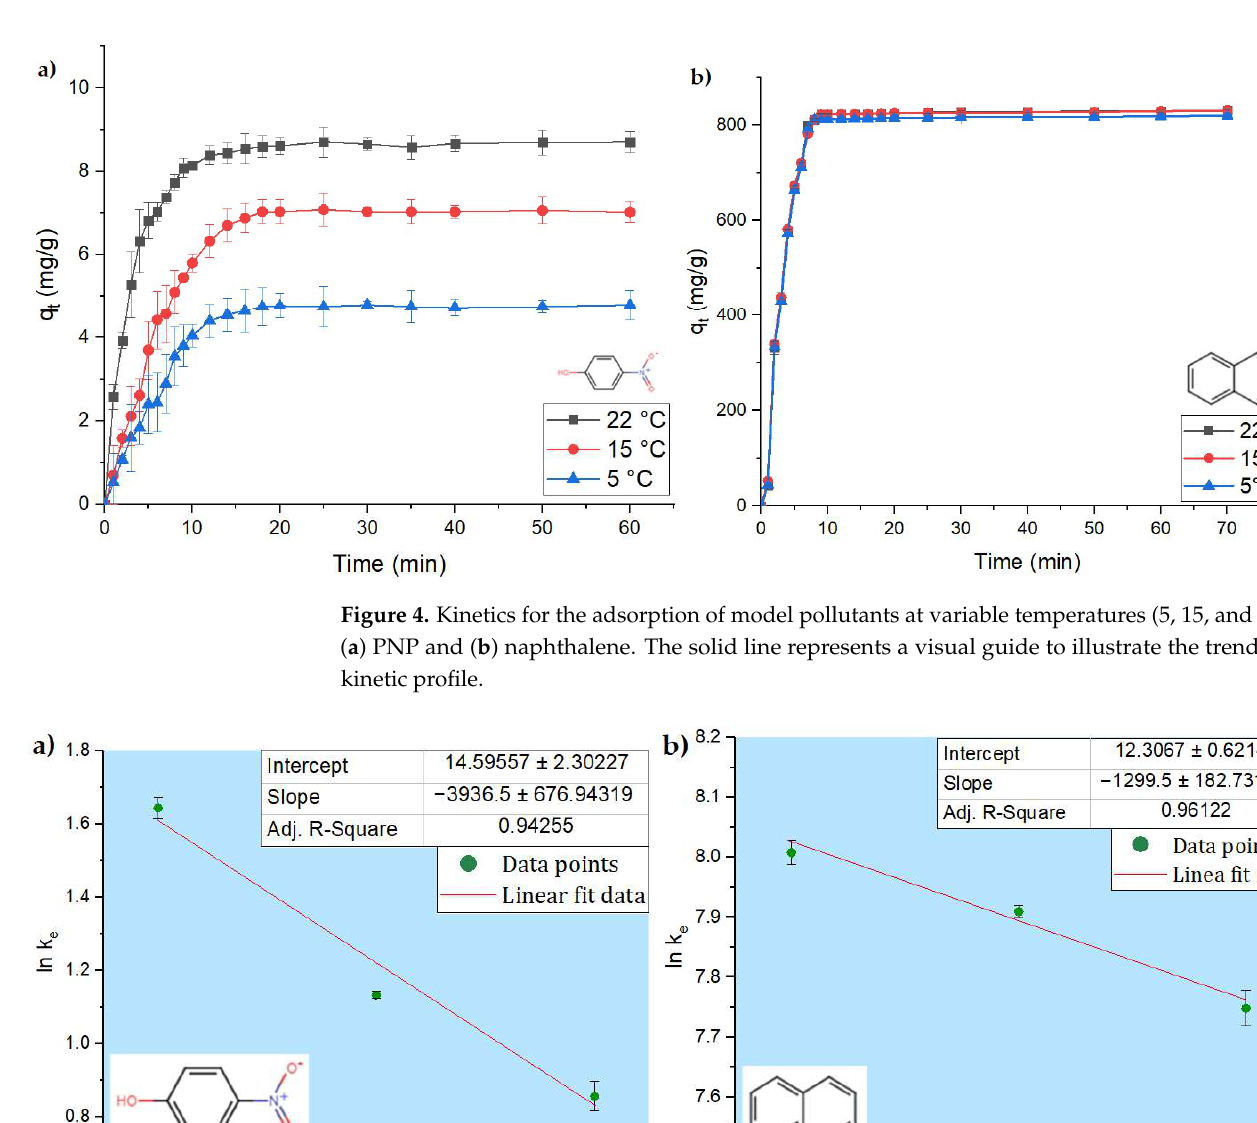
( b ) Figure 5. van ’t Hoff plots for the model hydrocarbons in the adsorption process: ( a ) PNP and ( b ) naphthalene.